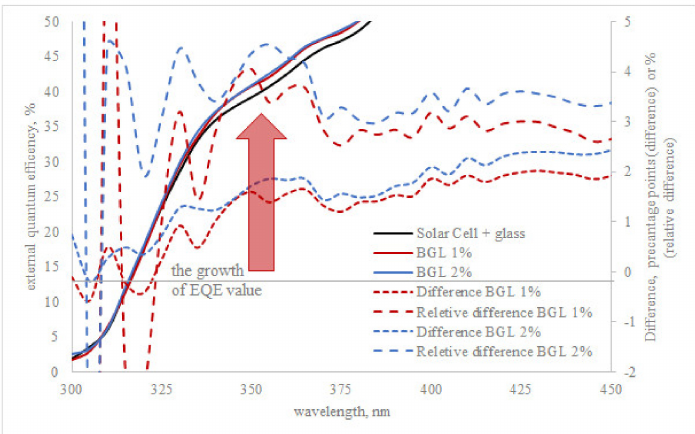
Figure 6. The best improvement of EQE for BGL pigment in only-PMMA variant.